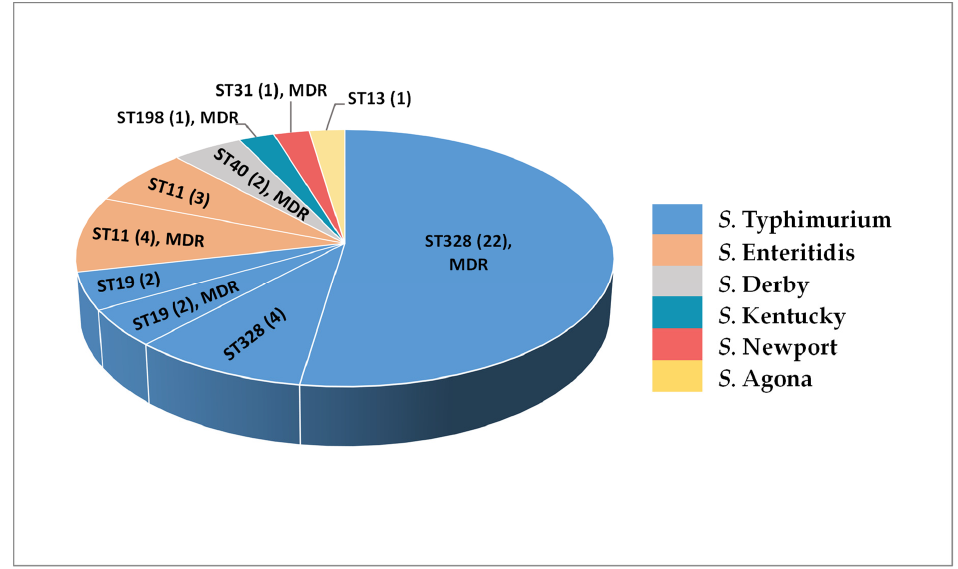
Figure 4. Serotypes and sequence types (ST) of 42 human non ‐ typhoidal Salmonella (NTS) isolates from Armenia determined by whole genome sequencing (WGS). MDR, all phenotypically multi ‐ drug ‐ resistant.